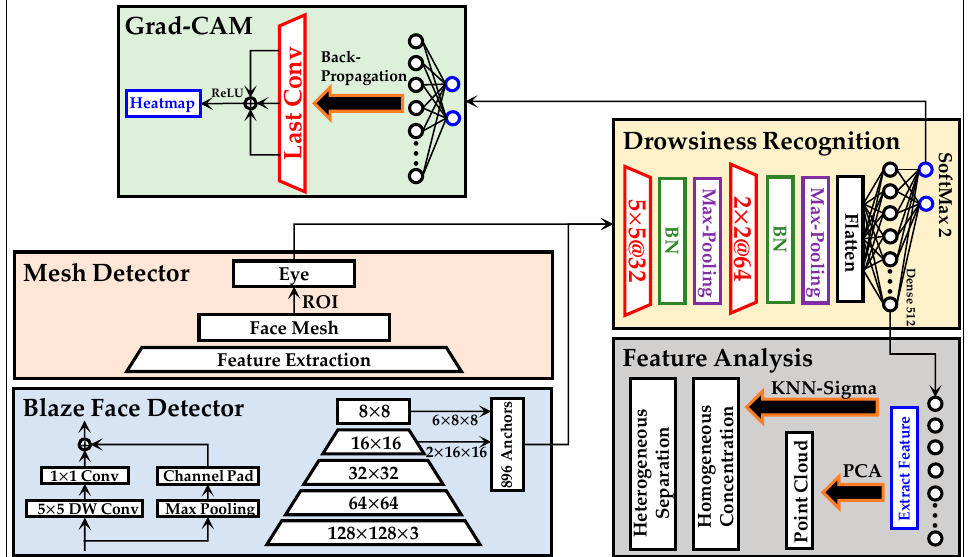
Figure 3. The experimental diagram in this work.